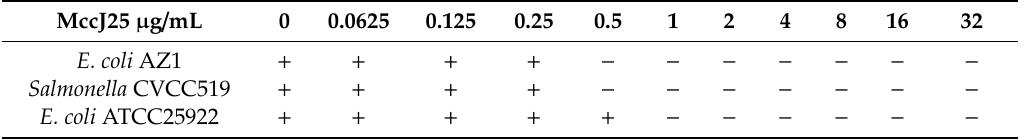
Table 2. Minimum inhibitory concentration (MIC) of microcin J25 (MccJ25) against E. coli AZ1 and Salmonella CVCC519.